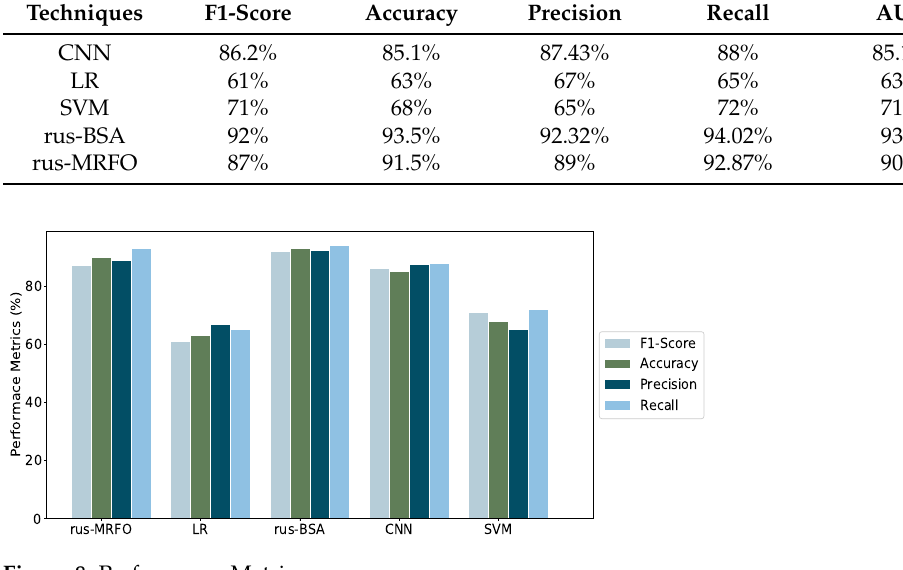
Figure 8. Performance